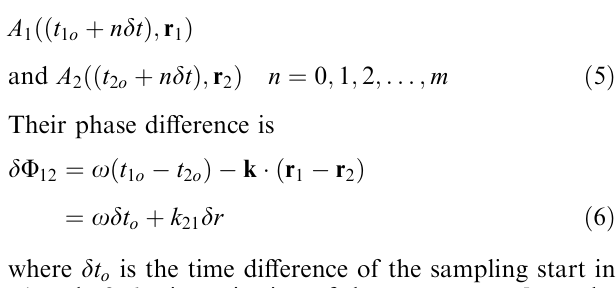
Fig. 2. a Amplitude ( top ) and argument ( bottom ) of the cross-spectral density estimated with the maximum entropy method for two time series, composed of a sinusoidal wave with a period of 72min and a Gaussian random series. b The same as a but composed of two